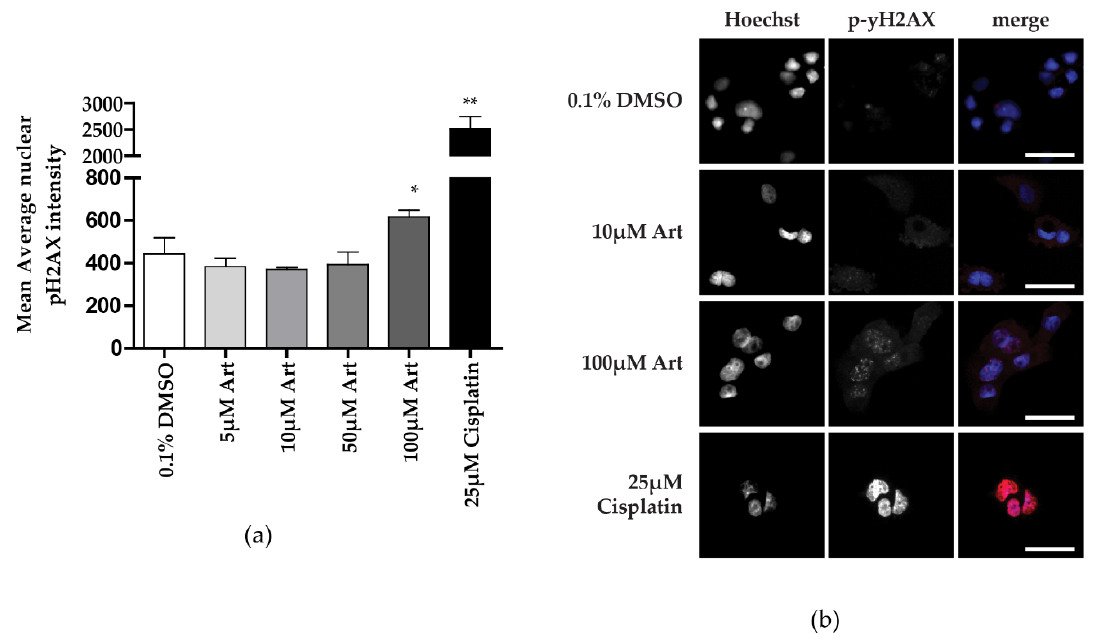
Figure 3. DNA damage assay as average nuclear pH2AX intensity. ( a ) The average nuclear intensity of pH2AX staining was quantified in Caov-3 cells treated for 48 h with artesunate concentrations ranging from 5–100 µ M with 25 µ M cisplatin treatment as a positive control. The mean signal +/ − SD was graphed and a one-tailed t -test was performed (* p = 0.0486, ** p = 0.0034) ( b ) Representative images of cells treated with 0.1% DMSO (vehicle), 10 µ M artesunate, 100 µ M artesunate, or 25 µ M cisplatin (positive control for DNA damage).